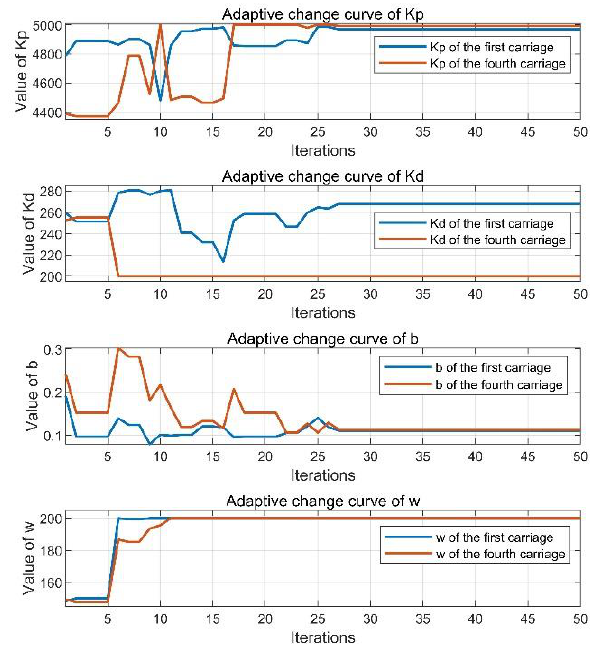
Figure 5. LADRC parameters change curve.